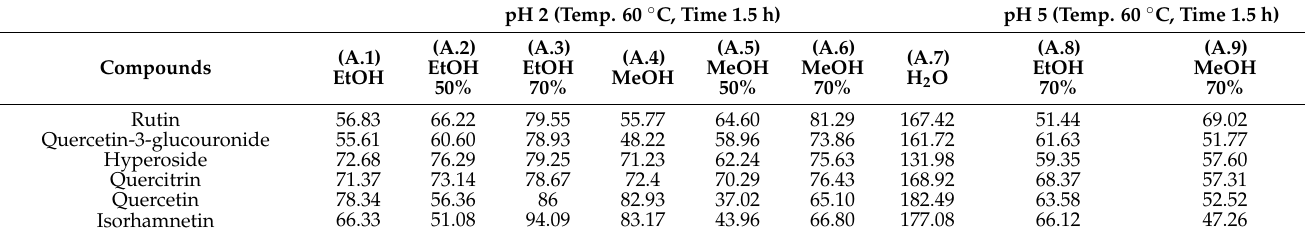
Table 4. Recovery percentages ( n = 2) for acidic hydrolysis method.